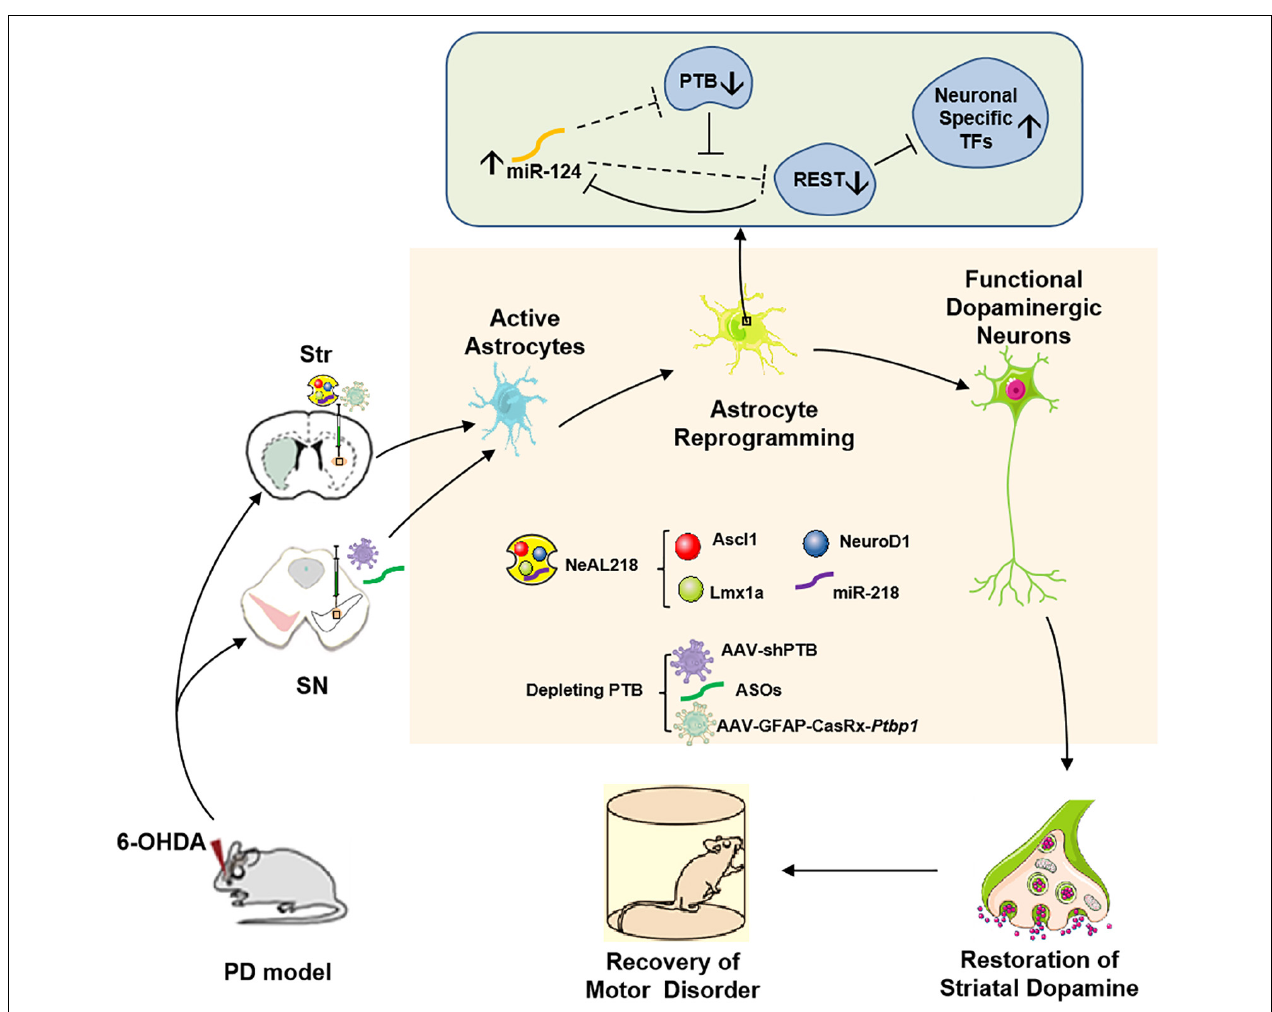
FIGURE 1 | In vivo reprogramming of astrocytes into functional dopaminergic neurons promotes behavioral improvement in a mouse model of PD. Astrocytes can be converted into dopaminergic neurons by high expressing three transcription factors (NeuroD1, Ascl1, and Lmx1a), and miR-218, collectively referred to as NeAL218 in mouse striatum (Fyfe, 2017; Rivetti di Val Cervo et al., 2017) or by depleting an RNA-binding protein called PTB in mouse striatum or substantia nigra (Qian et al., 2020; Zhou et al., 2020), which leads to behavioral improvement in a mouse model of PD. The molecular mechanism of astrocyte-to- dopaminergic neuron conversion by depletion PTB is that RE1-silencing transcriptional factor (REST) complex prevents the expression of multiple neuron-specific transcriptional genes (for example Ascl1, NeuroD1) as well as miR-124 in astrocytes (Hu et al., 2018). Although REST also is the target of miR-124 in such loop, such targeting